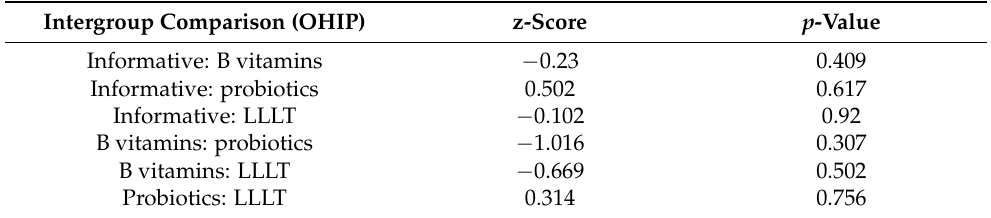
Table 4. Intergroup comparison of the percentage decrease in OHIP values ( p > 0.05, Mann–Whitney U test).